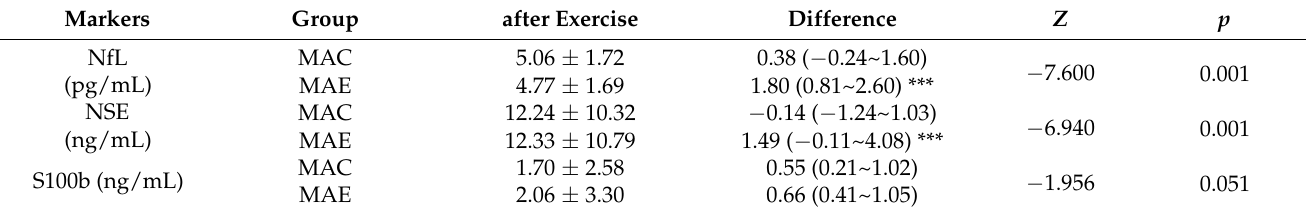
Table 6. Comparison results of the main outcome indicators after using multiple interpolation method.